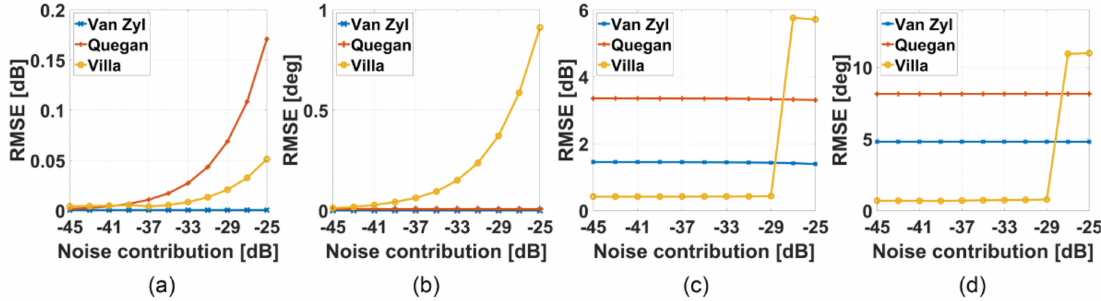
Figure 5. RMSE of ( a ) imbalances amplitude, ( b ) imbalances phase, ( c ) crosstalk amplitude, and ( d ) crosstalk phase variability due to the additive noise.